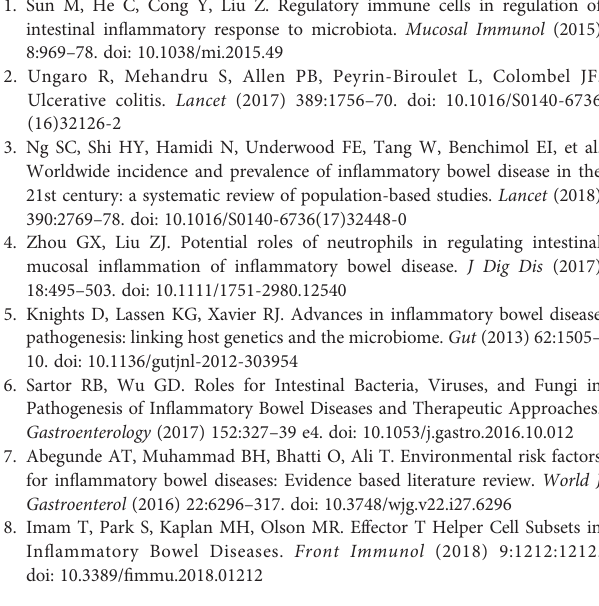
SUPPLEMENTARY FIGURE 2 | The correlation between plasma CRP levels and disease activity of UC. (A) Plasma CRP levels from UC patients with active UC (Mayo ≥ 3) or patients with UC in remission (Mayo <2) and healthy volunteers (active UC, n = 13, remission UC, n = 29, healthy volunteer, n = 11). *p < 0.05; **p < 0.01; ***p < 0.001. (B) The plasma CRP levels in the patients before (pre) and after (post) treatment. The CRP levels from the same patients were connected. (C – H) The correlations of the plasma CRP levels with the Mayo score (C) , Mayo endoscopic score (D) , WBC count (E) , serum Alb (F) , serum cholinesterase (G) , and platelet count (H) . SUPPLEMENTARY TABLE 1 | Scoring of the disease activity index in a DSS- induced colitis mouse model. Normal stool, well-formed pellets; loose stool, pasty and semi-formed stool that does not stick to the anus; diarrhea, liquid stool that sticks to the anus. SUPPLEMENTARY TABLE 2 | The histological scores in the DSS-induced colitis mouse